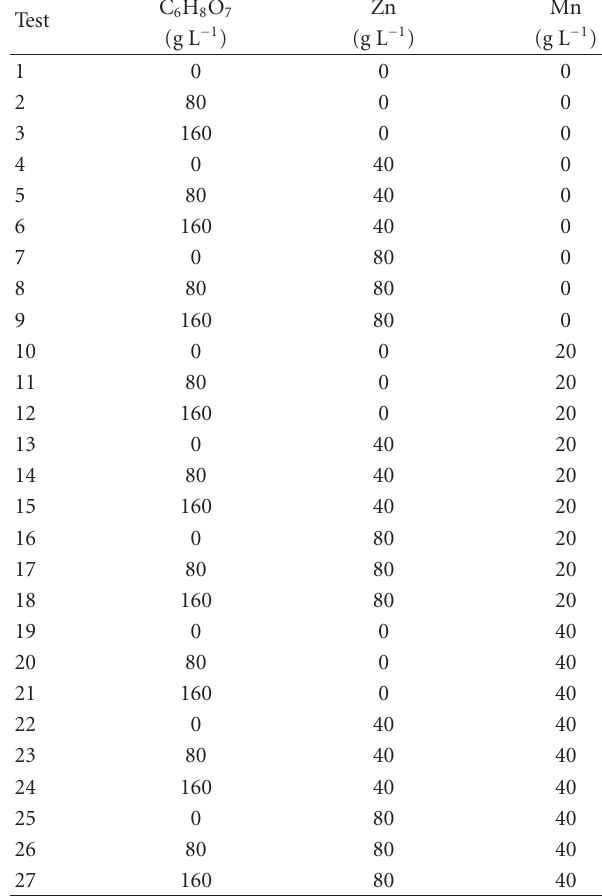
Table 5: Experimental conditions of the second series of precipita- tion tests: temperature 40 ◦ C without sulphuric acid.